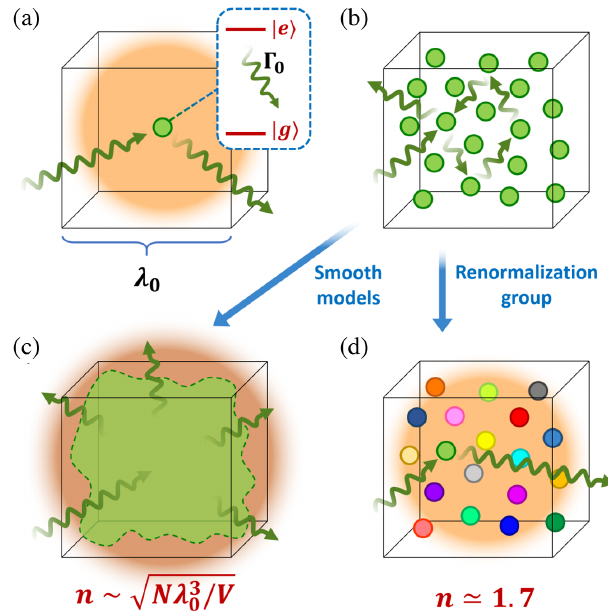
FIG. 1. Optical response of an atomic medium. (a) Illustration of a single atom with a dipole-allowed optical transition between ground and excited states, j g i and j e i , characterized by a transition wavelength λ 0 and spontaneous emission rate Γ 0 . Such an atom exhibits a scattering cross section (illustrated by ∼ λ 2 the shaded region) of σ 0 for a single resonant photon sc (wavy green arrows). (b) In a dense ensemble with many atoms per cubic wavelength λ 3 0 , the scattering of an incident photon can involve multiple scattering and interference between atoms. (c) In conventional theories of macroscopic optical response, the atoms are approximated by a smooth medium, and the index is derived from the product of single-atom polarizability and density. The maximum index n near the atomic resonance ffiffiffiffiffiffiffiffiffiffiffiffiffiffi p N λ 3 0 =V then scales with atomic density like n ∼ . (d) In our renormalization group theory, we retain multiple scattering and granularity, showing that the optical properties of the ensemble are determined by a hierarchy of nearby atomic pairs that strongly interact via their near fields. These interactions effectively produce an inhomogeneously broadened ensemble, where the amount of broadening scales with density (with the different colors of atoms representing the different resonance frequencies in the figure). An incident photon of a given frequency thus sees only about 1 near-resonant atom per reduced cubic wavelength to interact with, regardless of atomic density, resulting in a maximum index of n ≈ 1 . 7